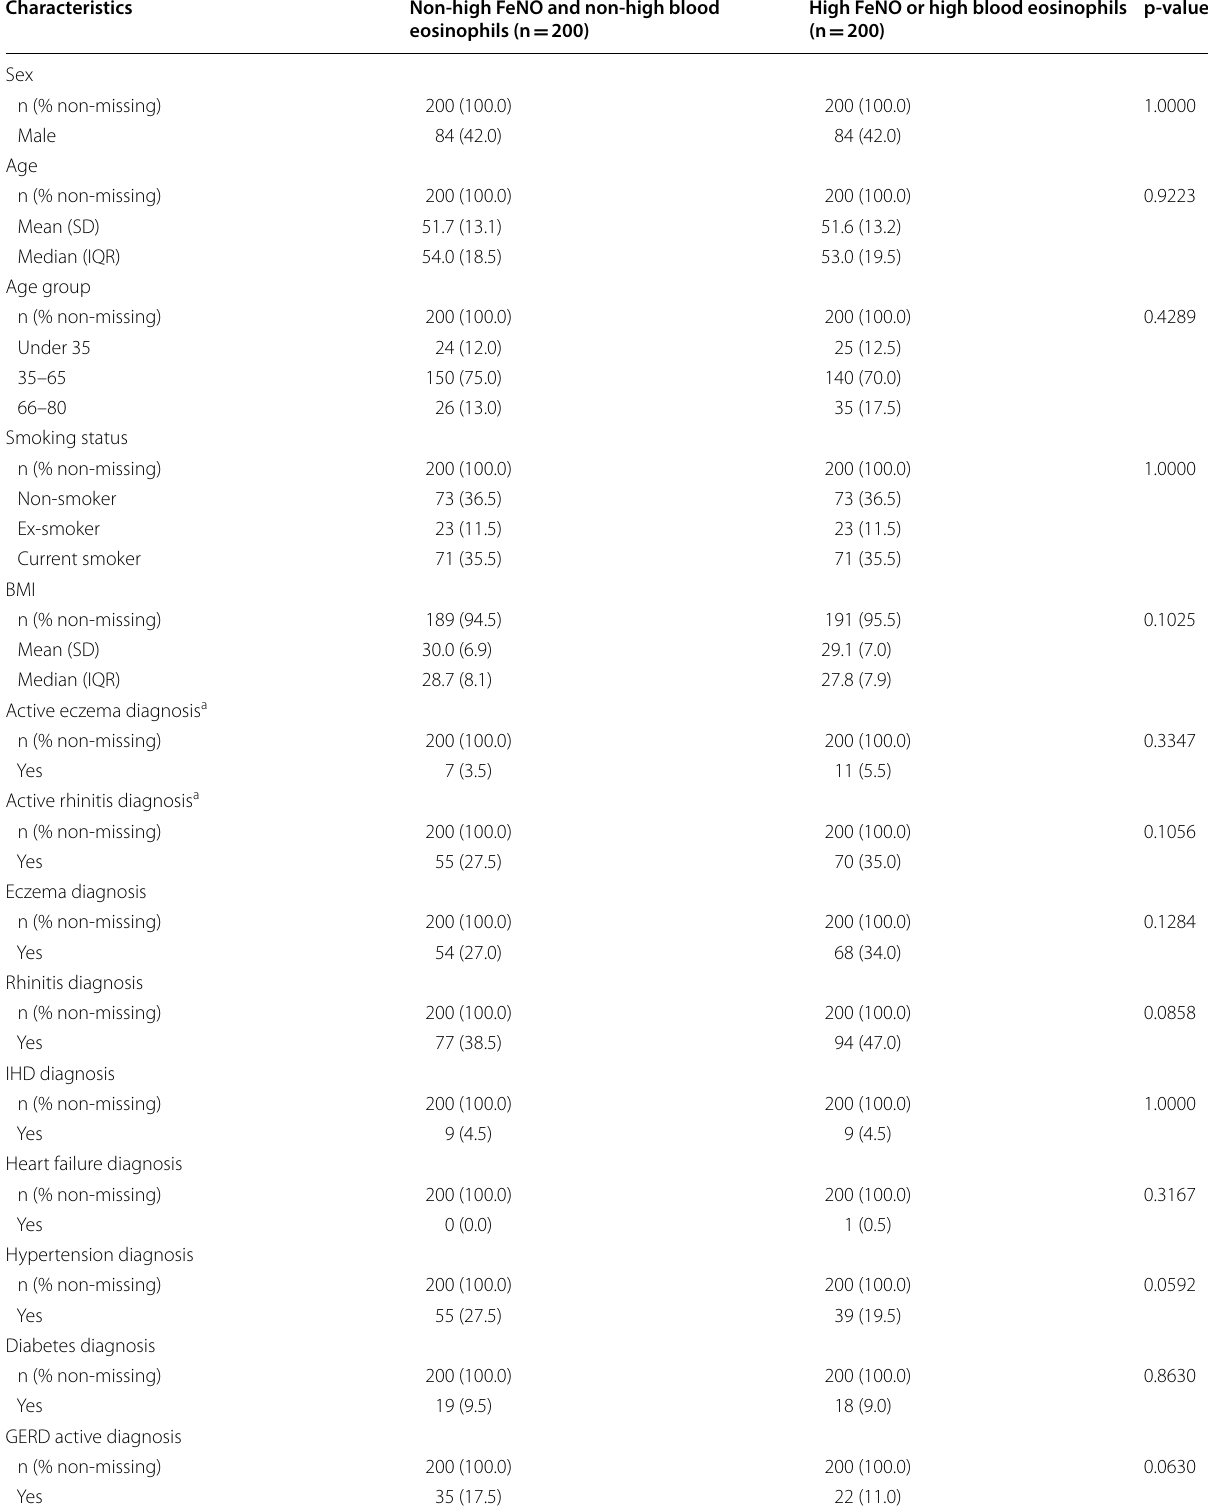
Table 2 Categorisation 1: non-high FeNO and non-high blood eosinophils vs. high FeNO or high blood eosinophils